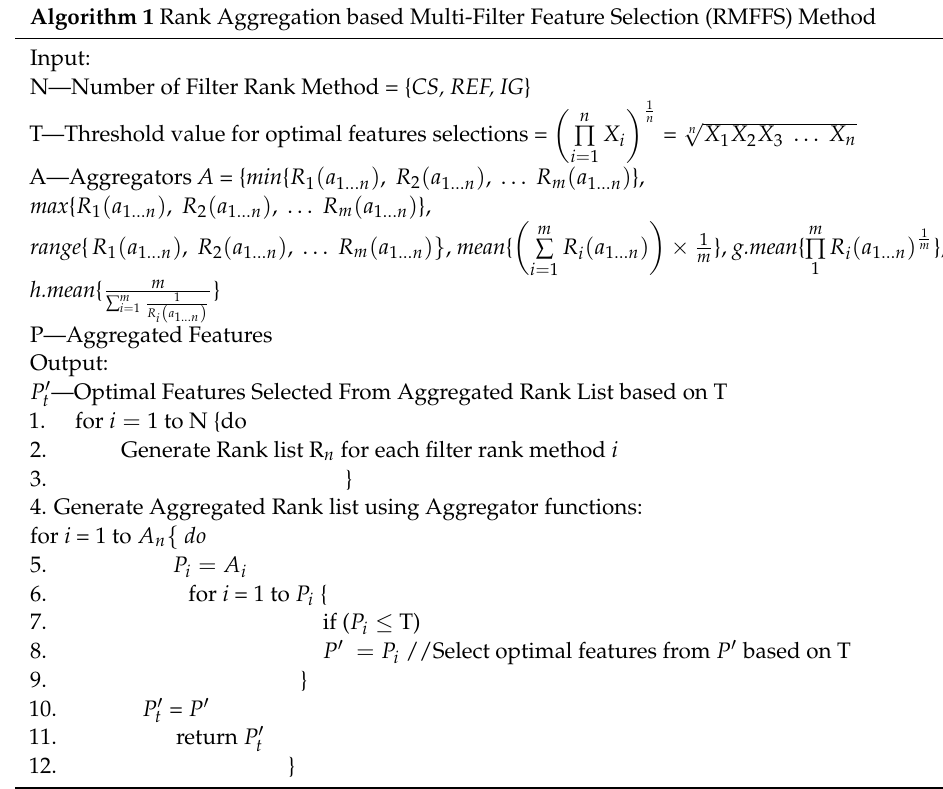
Algorithm 1 Rank Aggregation based Multi-Filter Feature Selection (RMFFS) Method